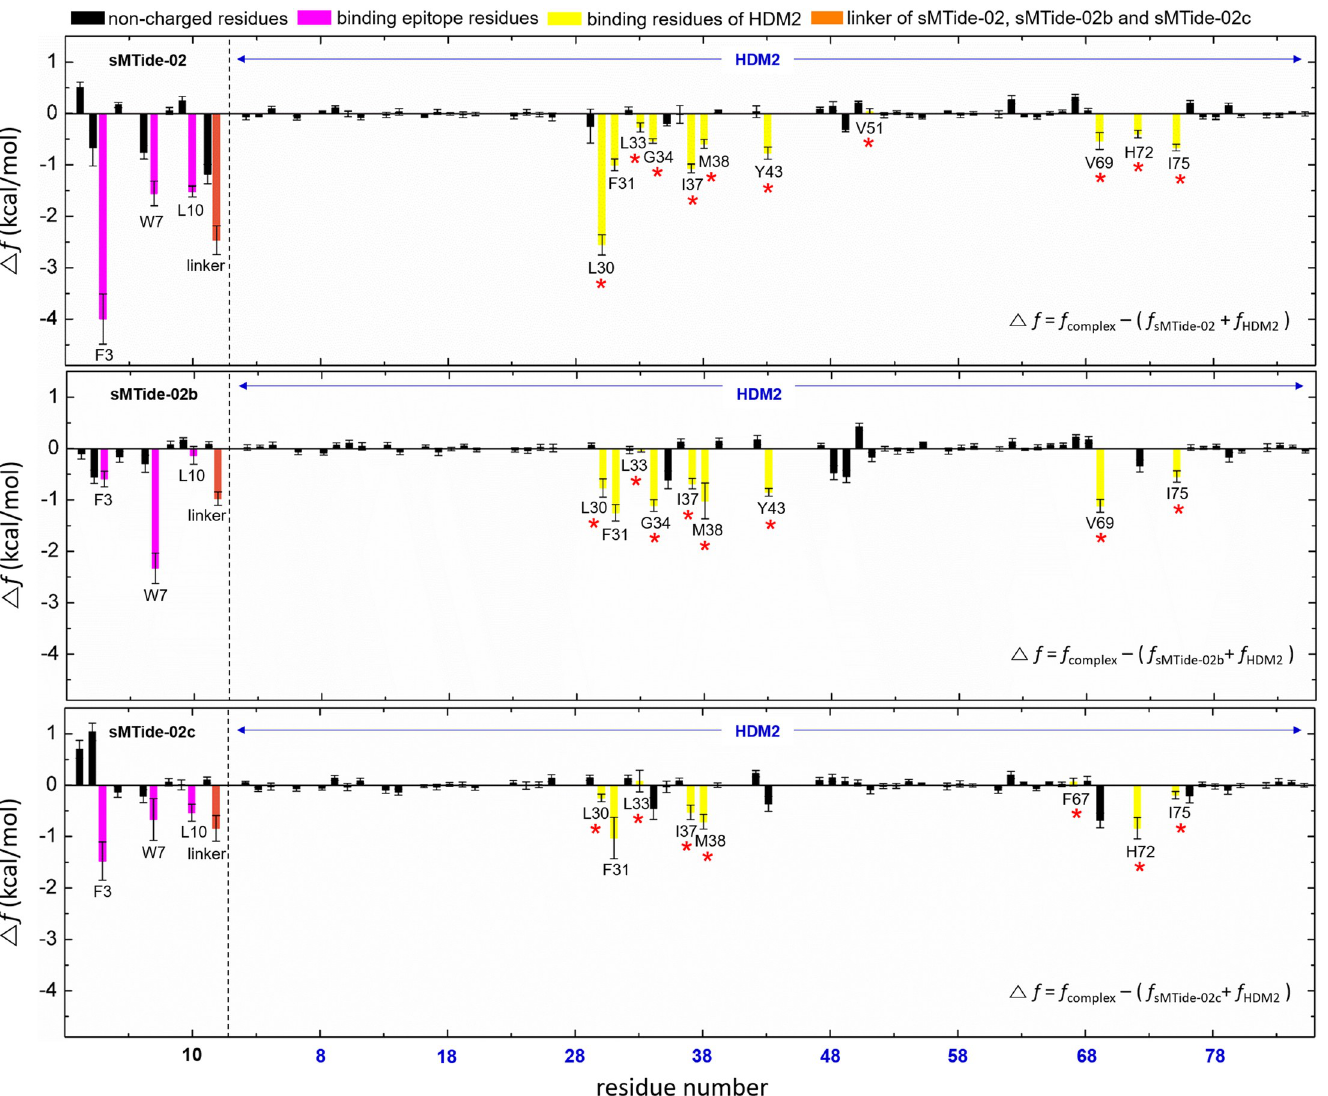
Fig 4. Analysis of the effective binding free energy ( Δ f ). The epitope residues of the stapled p53 peptides are colored magenta and the hydrocarbon linker is colored orange; hydrophobic residues located at the binding interface of HDM2 are colored yellow; and residues present in the wild-type p53/HDM2 binding interface are indicated by the red